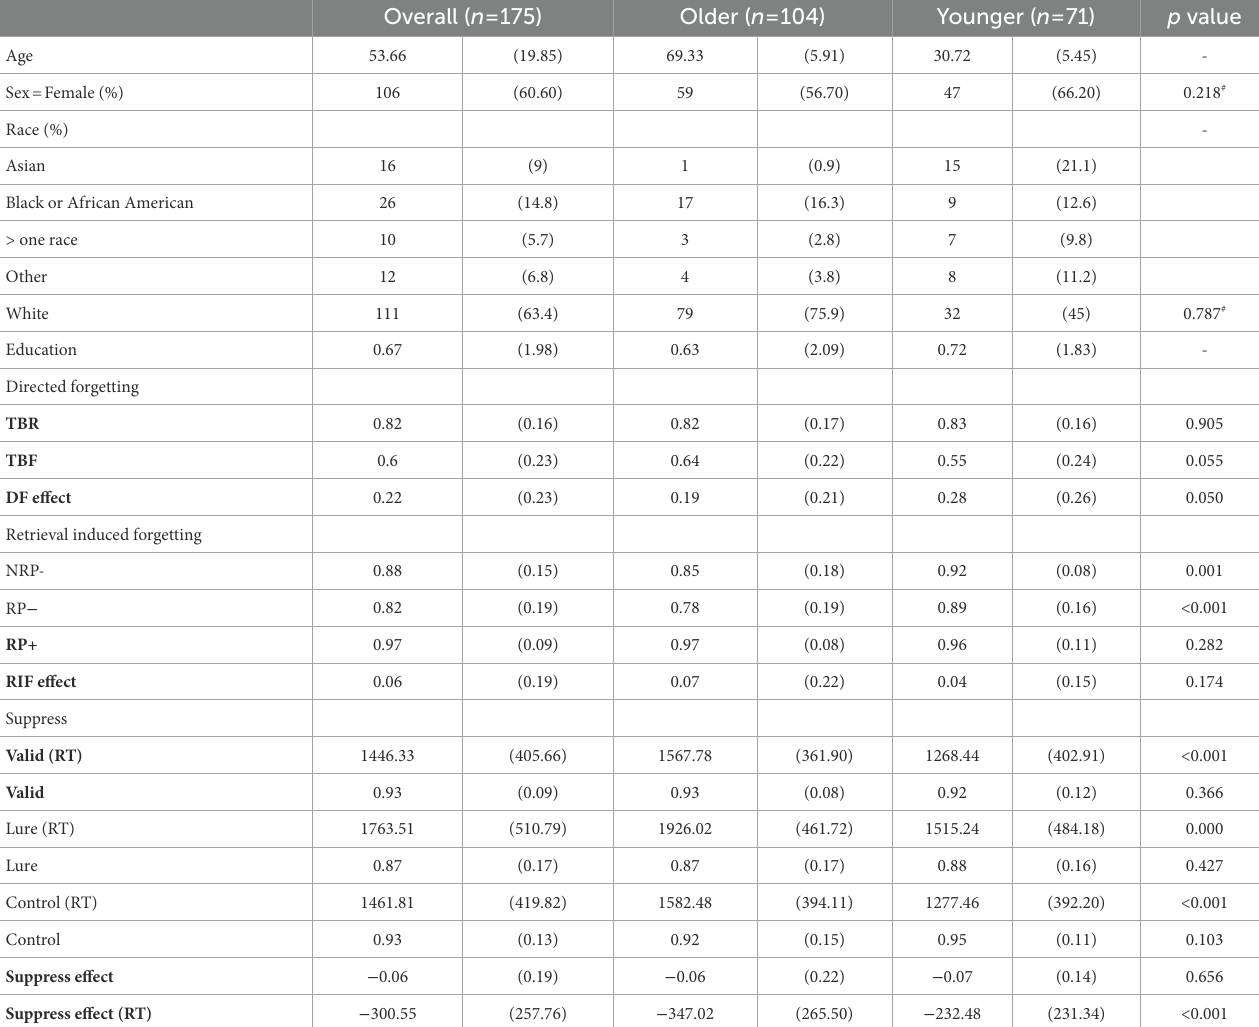
TABLE 1 Description of the sample and behavioral performance (mean, SD) for all task